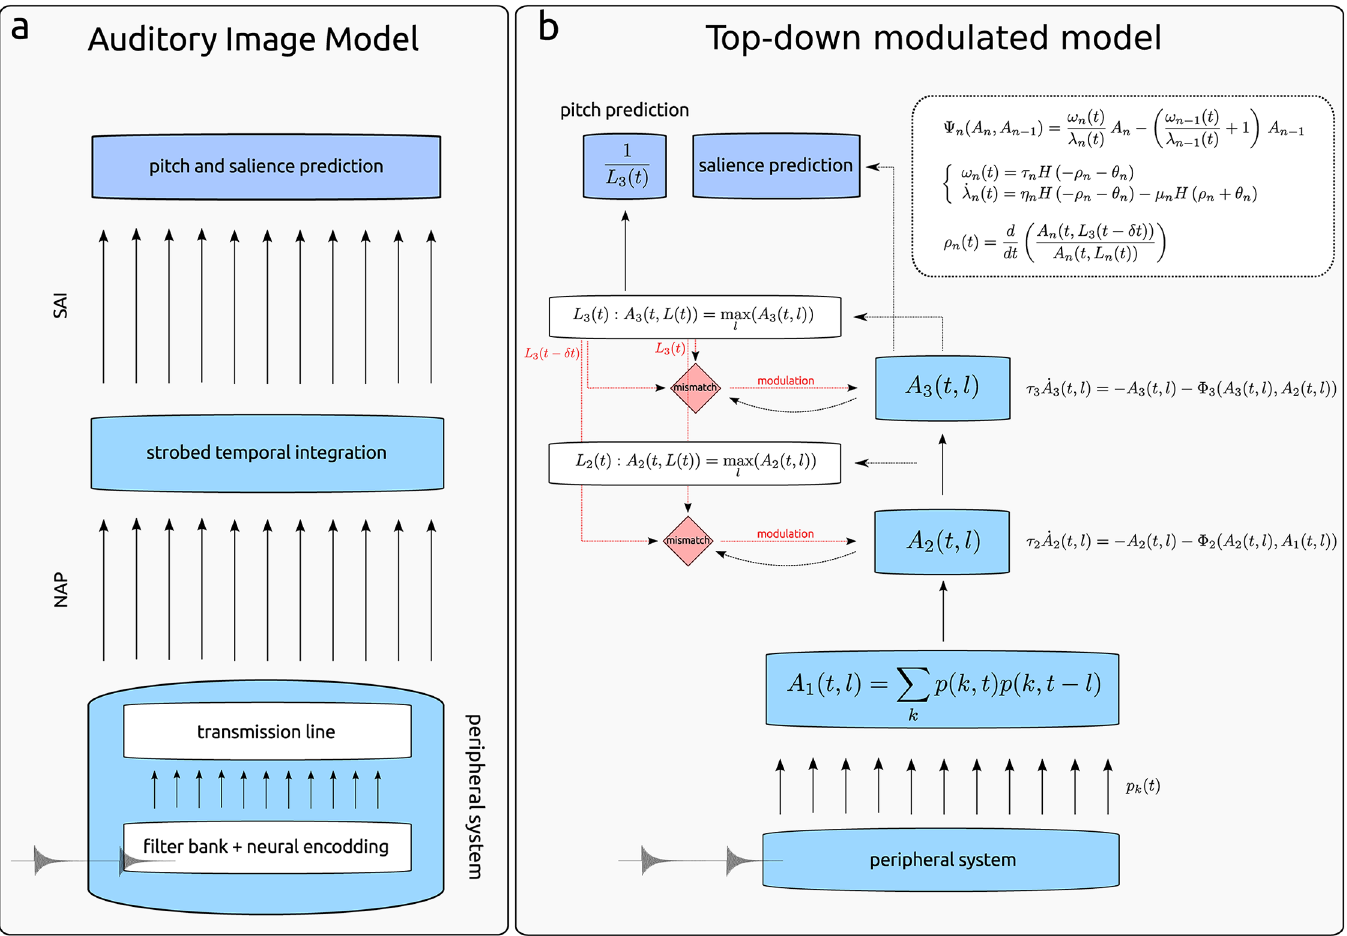
Fig 2. Schematic diagram of the Auditory Image Model and theTop-down Modulated Hierarchical Model of Pitch. a) Schematic view of the Auditory Image Model (AIM) [14]. In the first stage, peripheral auditory filters transform the input waveform into a multi-channel representation of basilar membrane motion. The next stage applies a hair cell model and converts this motion into a neural activity pattern in the auditory nerve (NAP). In the final stage, this signal is used to produce a stabilised representation of the stimuli by means of strobed temporal integration. The output of this process is termed the stabilised auditory image (SAI) of the input stimulus. b) Schematic view of the top-down modulated Hierarchical Generative Model of pitch perception (GPM) [17]. The peripheral processing is similar to the one in AIM (bottom). The next step consists of a coincidence detection process of auditory nerve activity patterns for different cochlear delay lines l , A 1 ( t , l ). Further processing is carried out by two consecutive ensemble models A 2 and A 3 performing leaky integrations of input activity using time-varying integration windows. Such ensembles correspond putatively to pre-thalamic and central auditory areas. A top- down, stimulus-dependent mechanism modulates the size of the effective integration windows of bottom-up